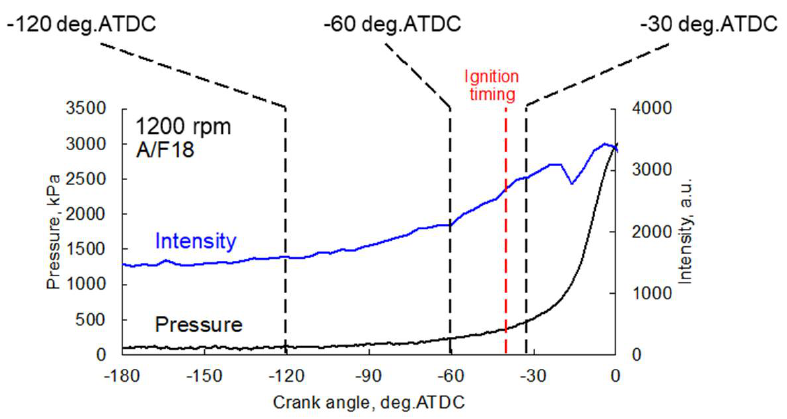
Figure 4. Seeding particle density variation in a cycle.